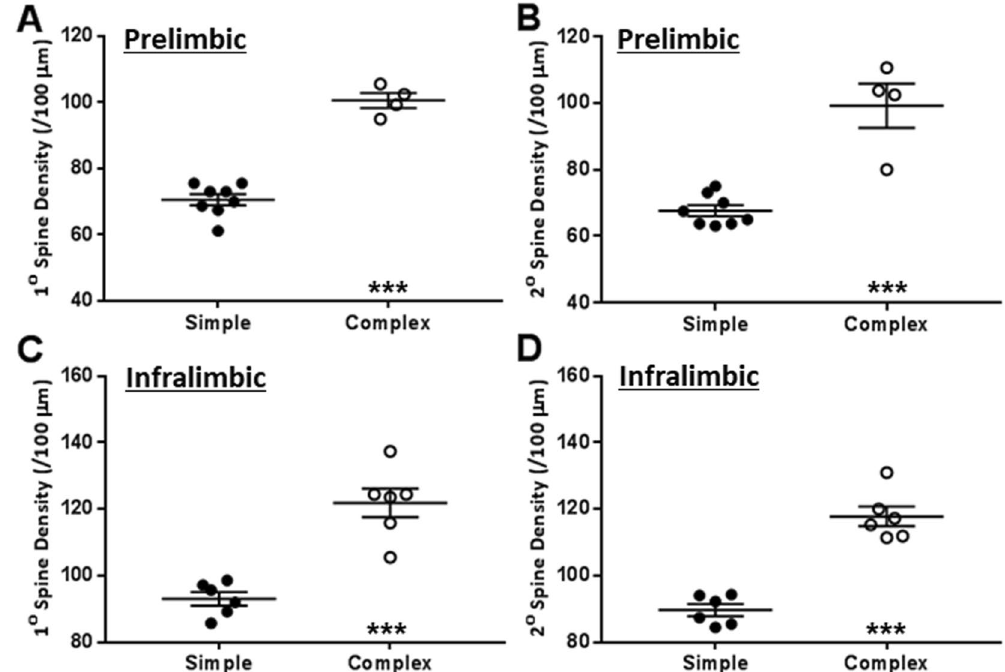
Figure 5. Complex environment increased density of spines of primary and secondary dendrites of the neurons in both prelimbic and infralimbic medial prefrontal cortex. *** p < 0.001; unpaired Student’s t-test. n = 8 animals for simple and 4 for complex environment (prelimbic); and, 6 animals for simple and 6 for complex environment